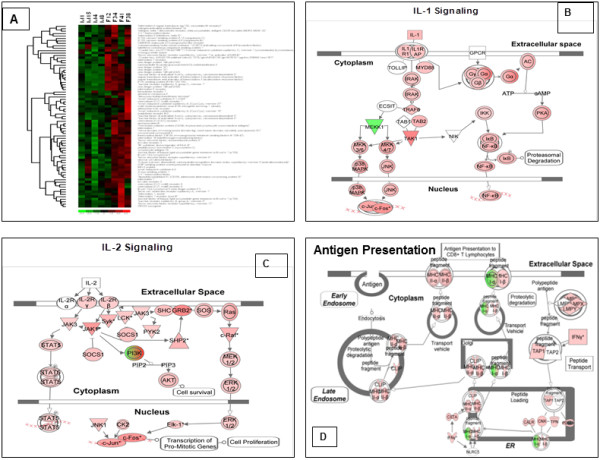
Pathways associated immune activation are upregulated in the gut mucosa in women. (A) A large cluster of the increased levels of gene transcription in the mucosal microenvironment includes genes and pathways associated with immune activation, antigen presentation and inflammation (M: male, F:female). Specific pathways that were upregulated in the microenvironment of the female gut mucosal tissue over baseline of male mucosal tissue include (B) IL1 Signaling, (C) IL2 Signaling and (D) Antigen presentation (Red: Increase in expression, Green: decrease in expression).